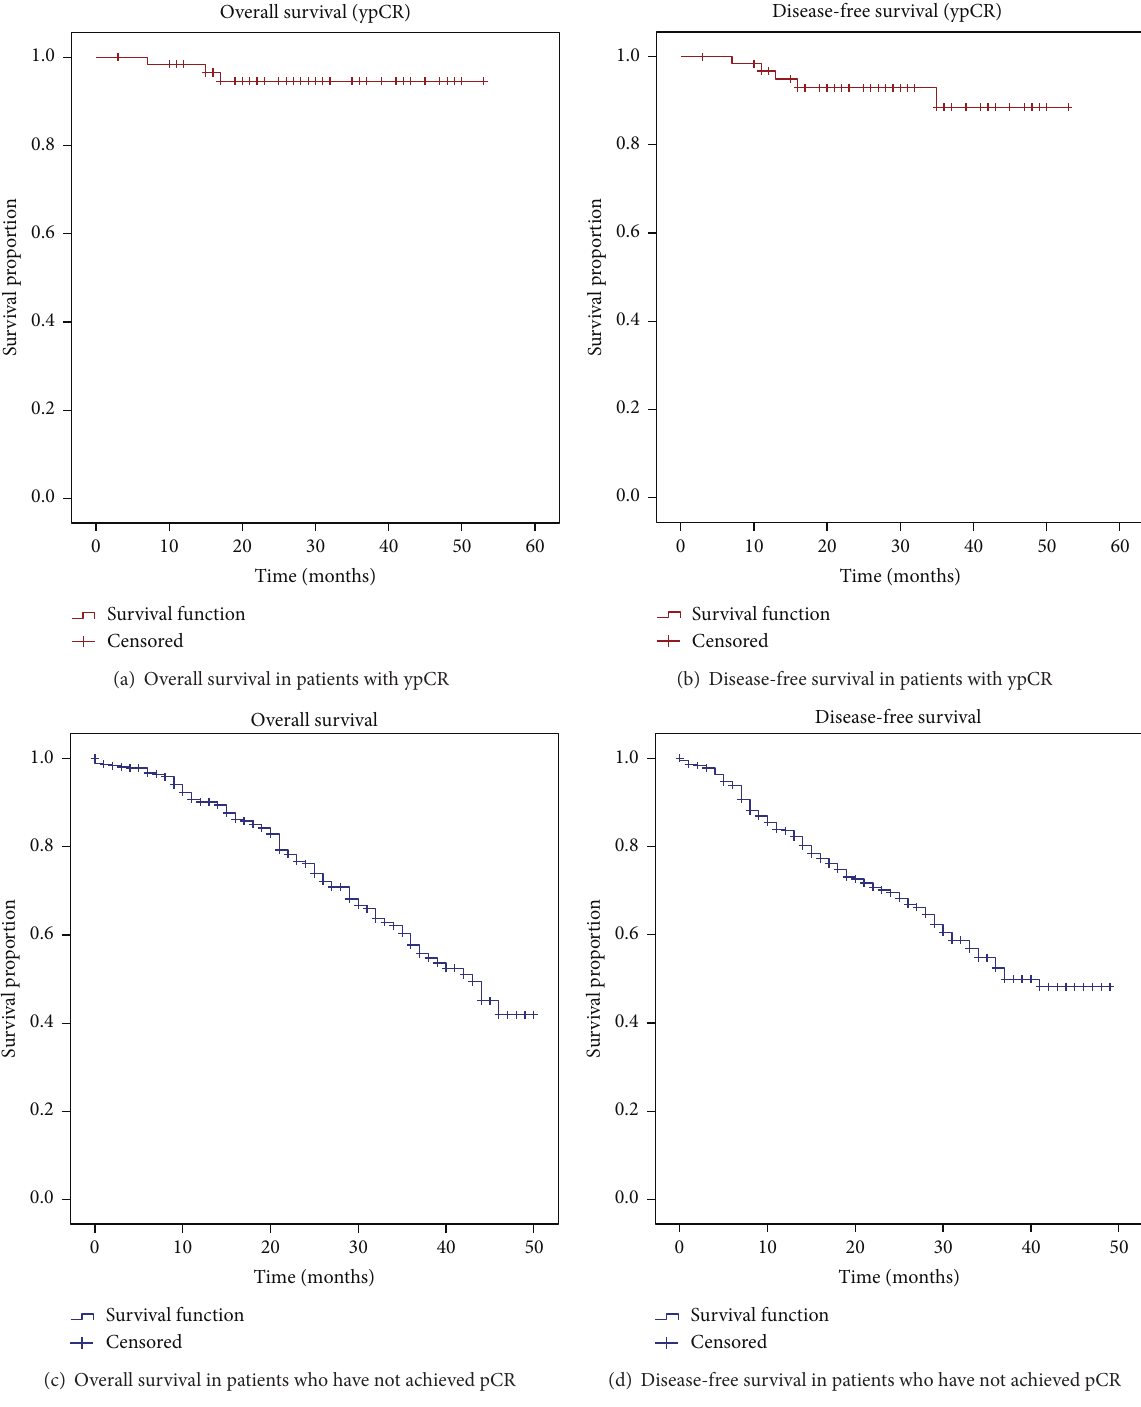
Figure 1: (a) and (b) Survival in patients with a complete pathological response (ypCR). (c) and (d) Survival in patients who have not achieved a complete pathological